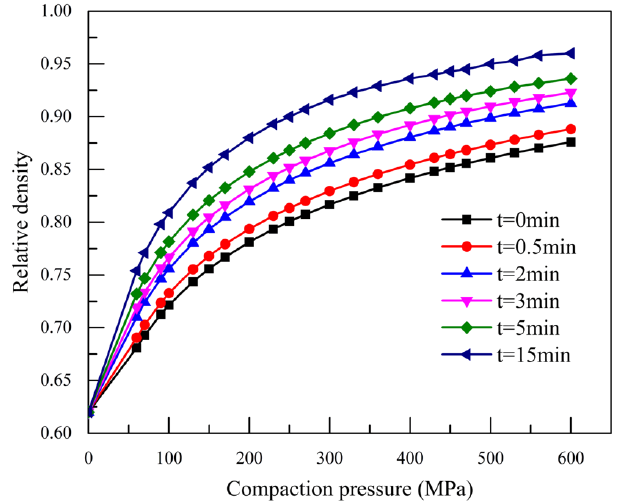
Figure 23. Evolution of average relative density with compaction pressure for different dwell times.